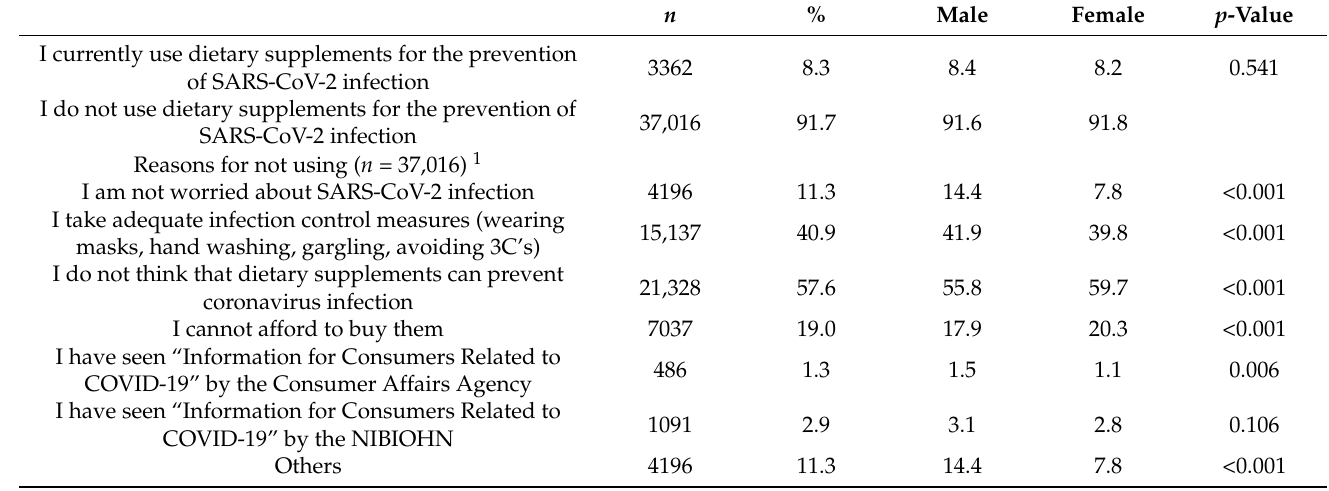
Table 3. The prevalence of dietary supplement usage for the prevention of SARS-CoV-2